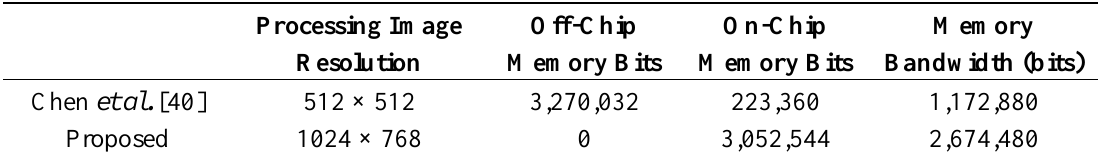
Table 2. Memory and bandwidth comparison results.